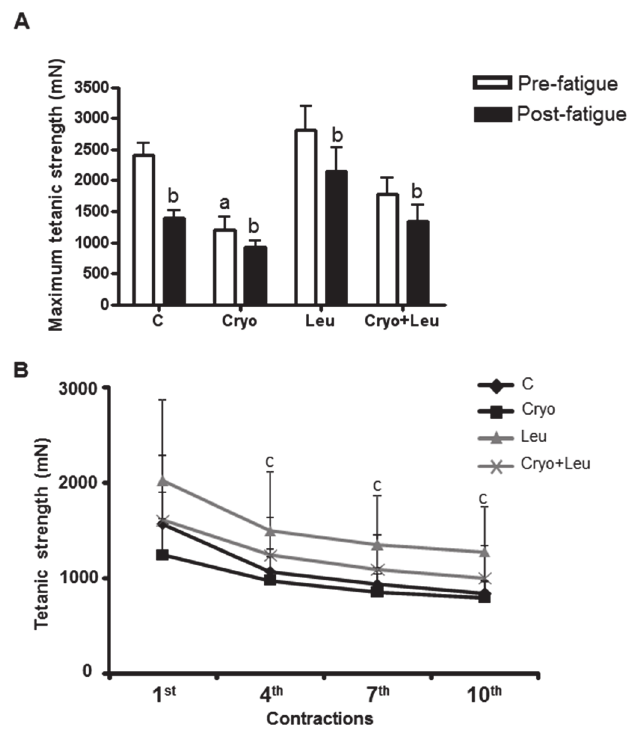
Figure 2. Maximum tetanic strength at pre-fatigue and post-fatigue protocol of TA muscles ( A ) analyzed on Day 10 post-cryolesion. a p < 0.05 vs. C and Leu; b p < 0.05 vs. pre-fatigue tetanic contraction from the same group. Development of muscle fatigue analyzed at four time points (first, fourth, seventh and tenth contractions) on TA muscles ( B ) on Day 10 post-cryolesion. c p < 0.05 vs. first contraction in all groups. C, intact control muscles; Cryo, muscles analyzed on Day 10 post-cryolesion; Leu, muscles after 13 days of leucine supplementation; Cryo + Leu, leucine supplemented group analyzed on Day 10 post-cryolesion. Muscle strength is expressed in millinewtons (mN). Data are presented as the mean ±